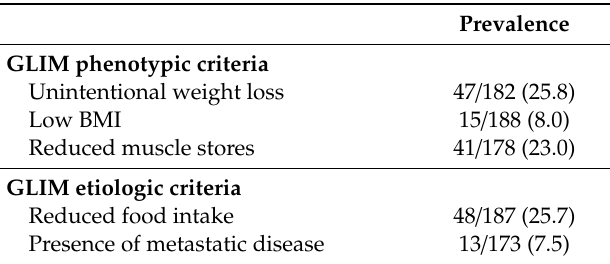
Table 5. GLIM criteria